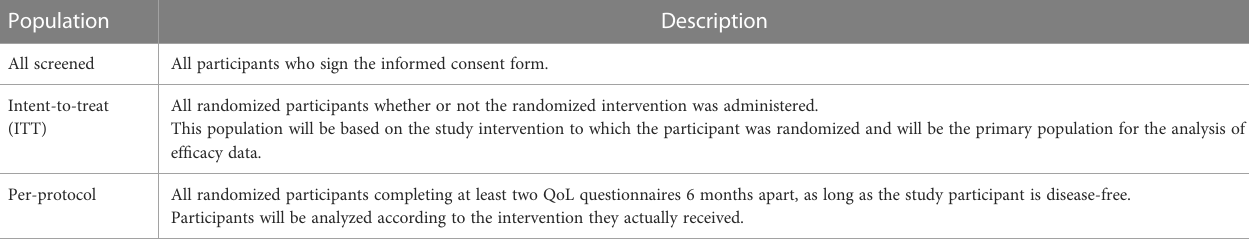
TABLE 3 Populations for